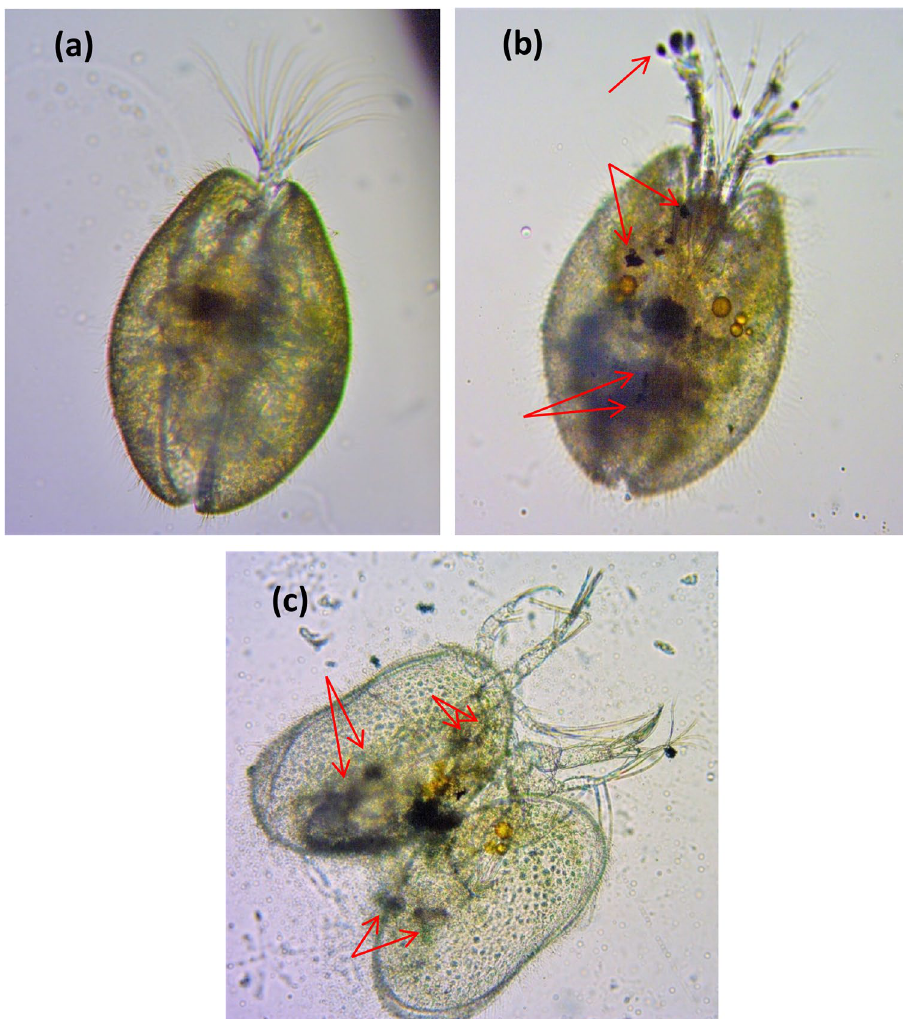
Figure 2. Optical microscope images of the ingestion of PANI/Ag (AMPSA)/GO QDs (red arrows) by Ostracods (×40 magnification) after 24 h exposure to 150 mg/L PANI/Ag (AMPSA)/GO QDs. The control is clear of PANI/Ag (AMPSA)/GO QDs ( a ), PANI/Ag (AMPSA)/GO QDs is visible as dark aggregates inside the body of treatment ( b ) and a dead Ostracod was ingested PANI/Ag (AMPSA)/GO QDs ( c